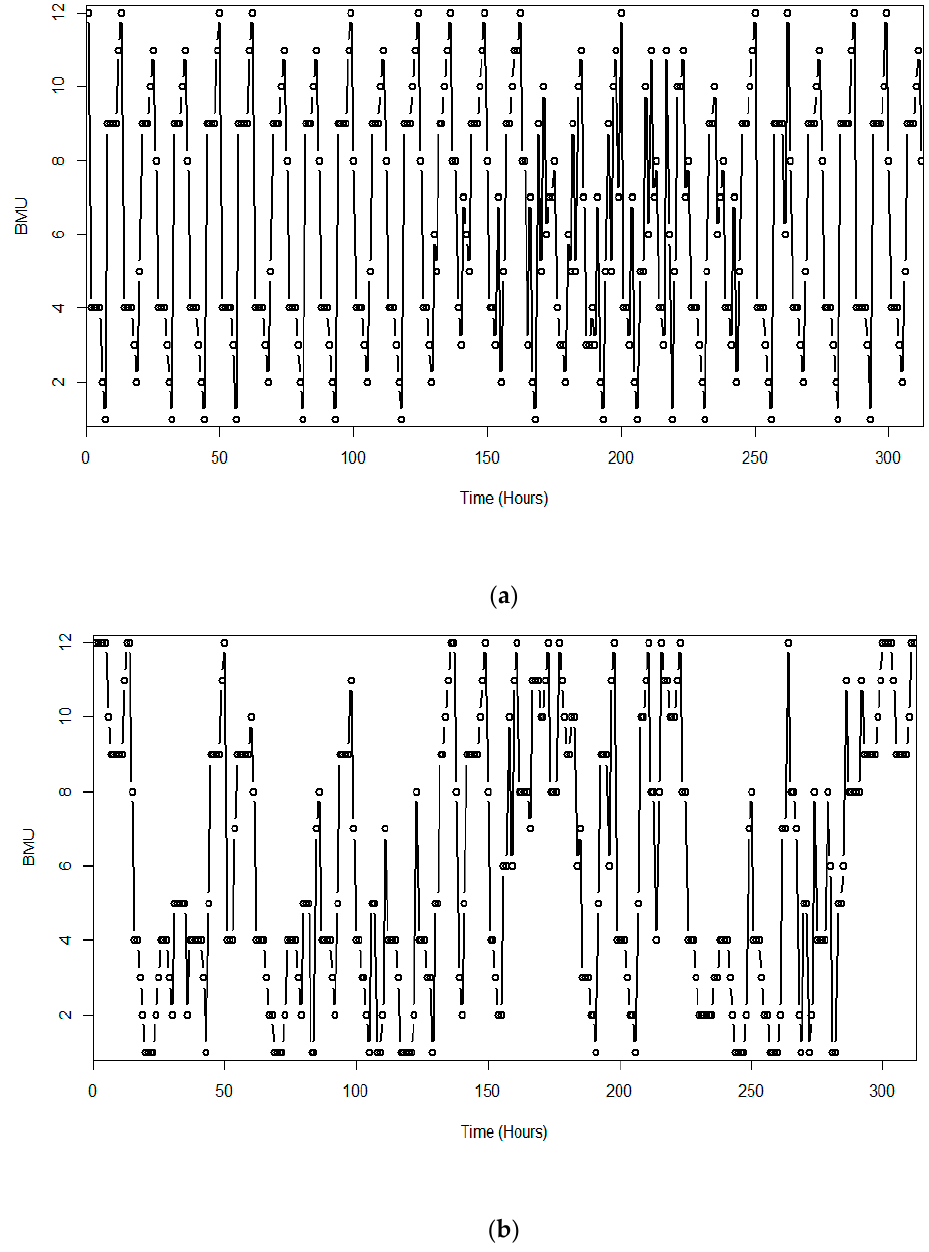
Figure 7. Time series of best match unit ( BMU ) corresponding to 12 SOM patterns (( a ) model results and ( b ) radar data).